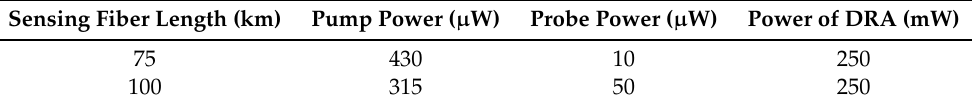
Table 1. Pump, probe power and power of DRA lasers for 75 and 100 km sensing range.